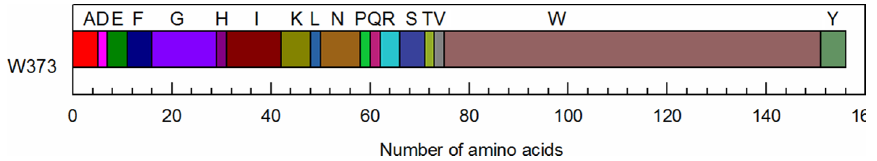
Figure 1. Bioinformatics-based estimation of variability in the set of 167 b -glycosidases defined by Zhao et al. [13] at the position corresponding to W373 in b -glucosidase Zm-p60.1. The whole alignment is included as File S2 and S3.